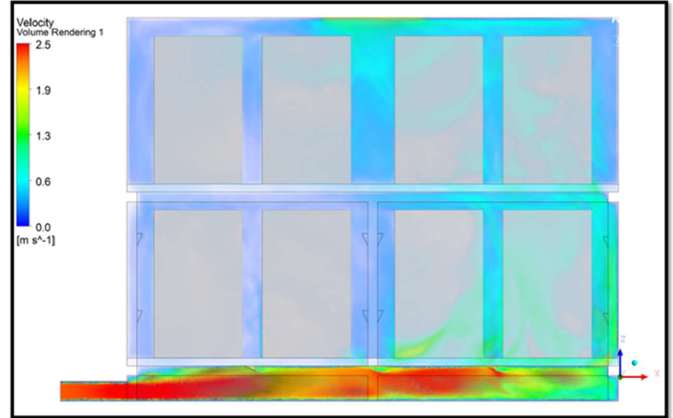
Figure 19. Vented model battery temperatures resulting from simulation.